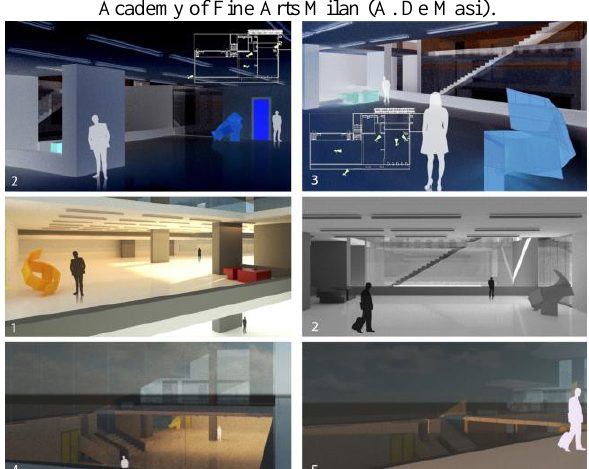
Figure 12 . New Bocconi University headquarters in Milan - Grafton building in via Röntgen (2008). Resilience area: Resilient models with the elements of visual shooting. Brera Academy of Fine Arts Milan (A. De Masi). b) Deconstructivism with design / chromatic innovations, passage to imbalance, chromatic-formal dynamism, to the instability of forms (tortuous, asymmetrical surfaces, sinuous lines, swirling spirals) and the use of primary colors; c) color, light and nature to combine, through design transparencies, shades of gray, light and nature within the projects (see Bauhaus headquarters in Dessau, teaching